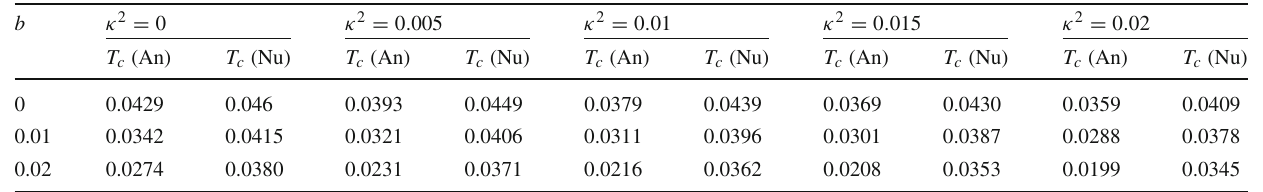
Table 3 Analytical and numerical results of T c /μ for different values of κ and